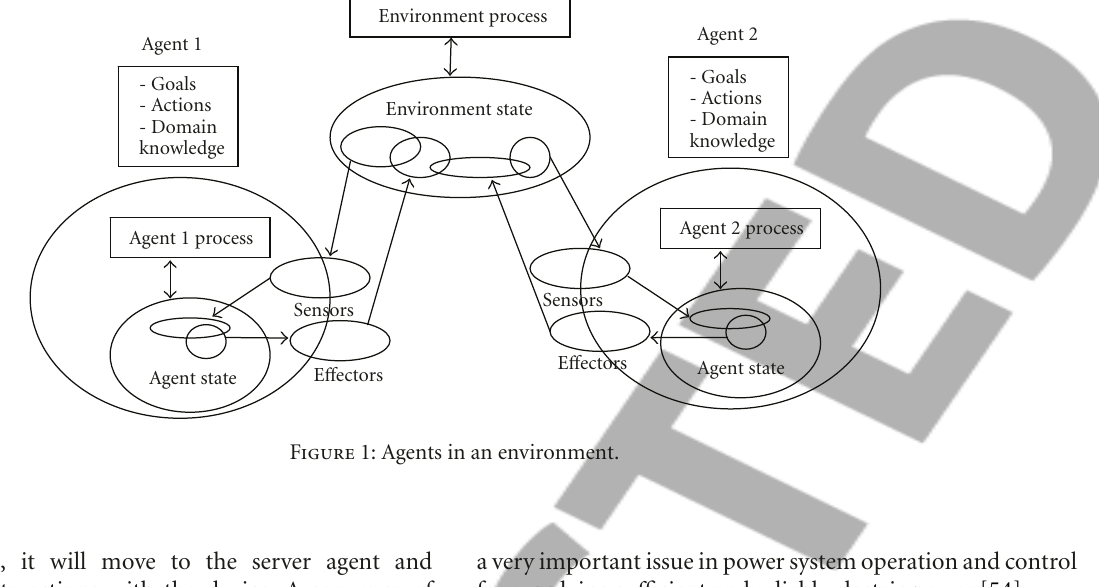
Figure 1: Agents in an